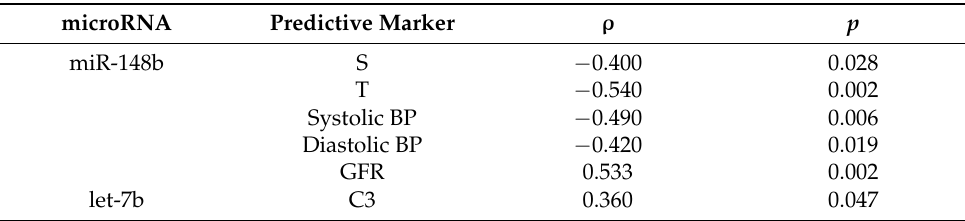
Table 2. Correlation of microRNA with predictive markers of IgA